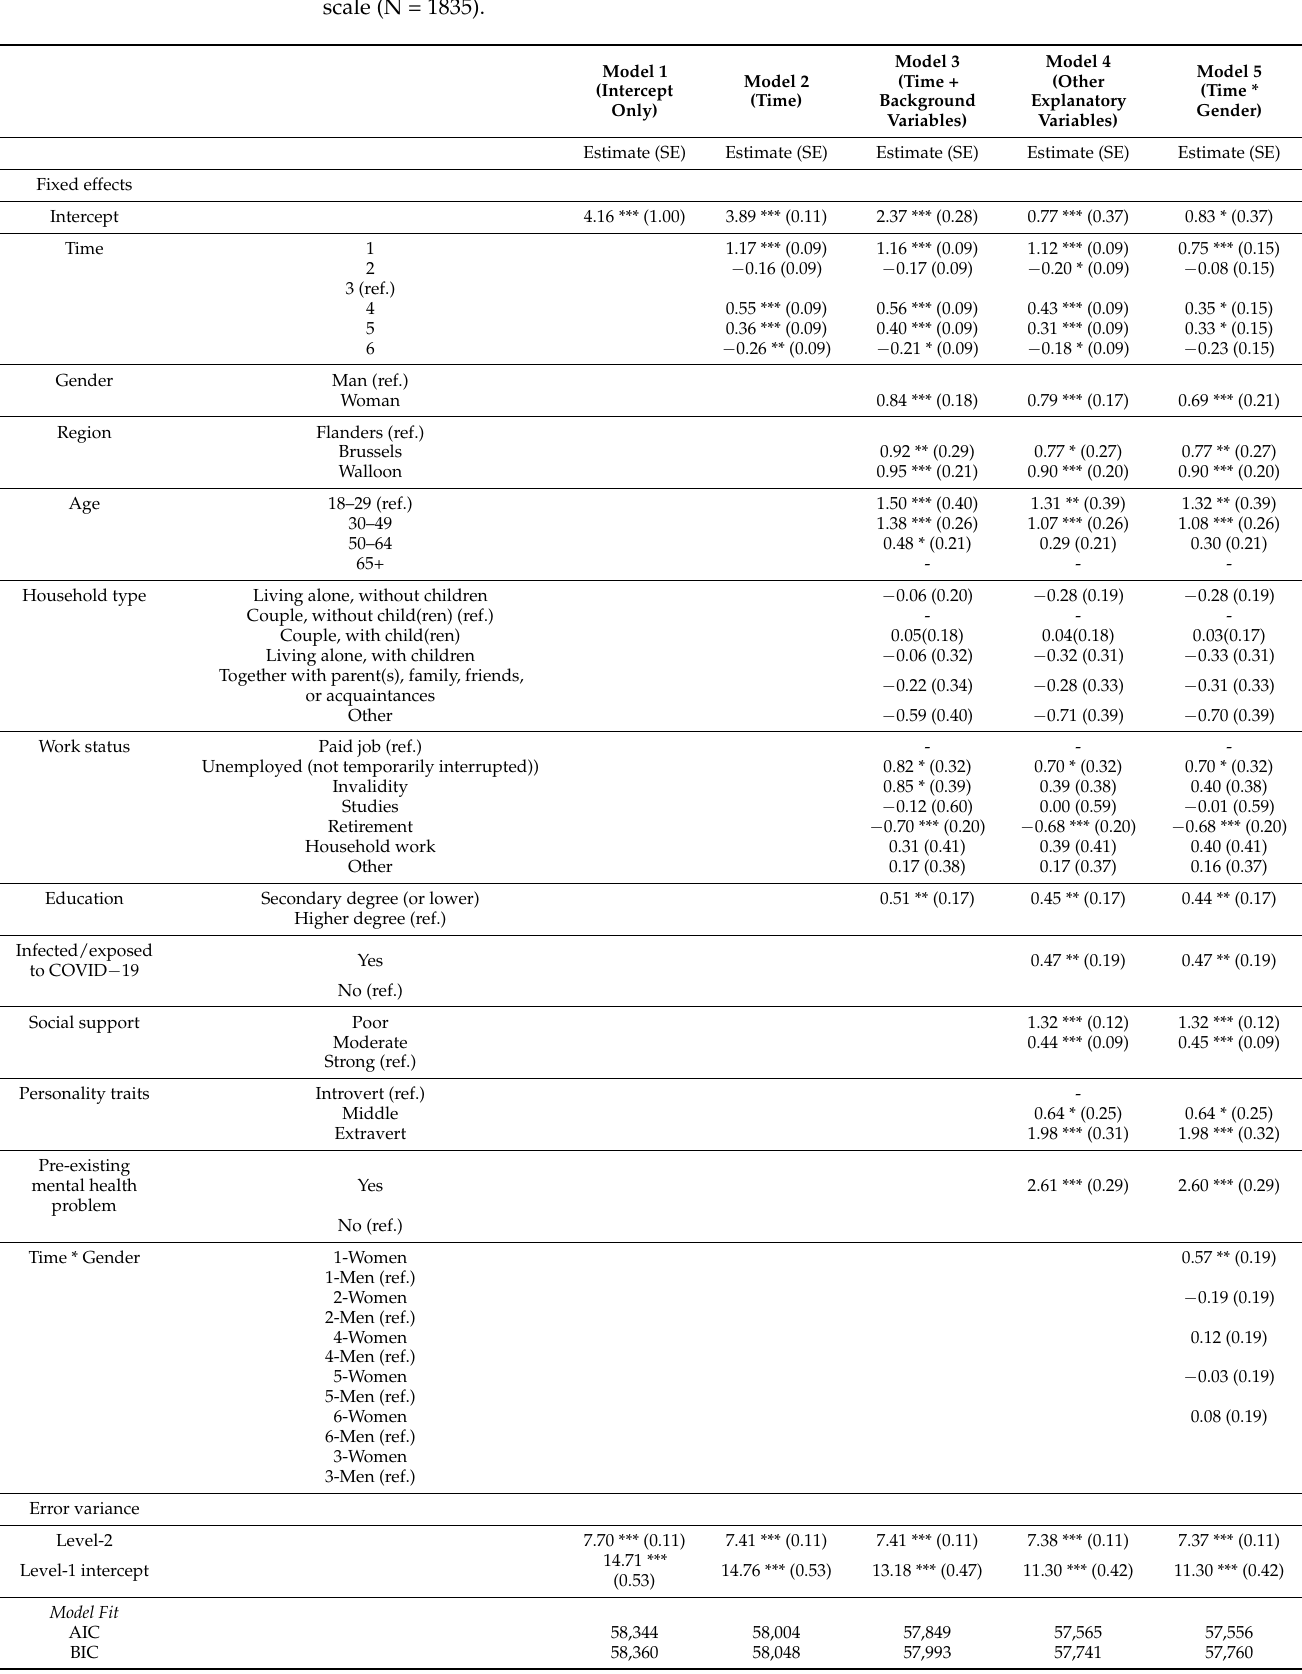
Table 3. Estimates (SE) from linear mixed models examining the total score on the GAD-7 anxiety scale (N =